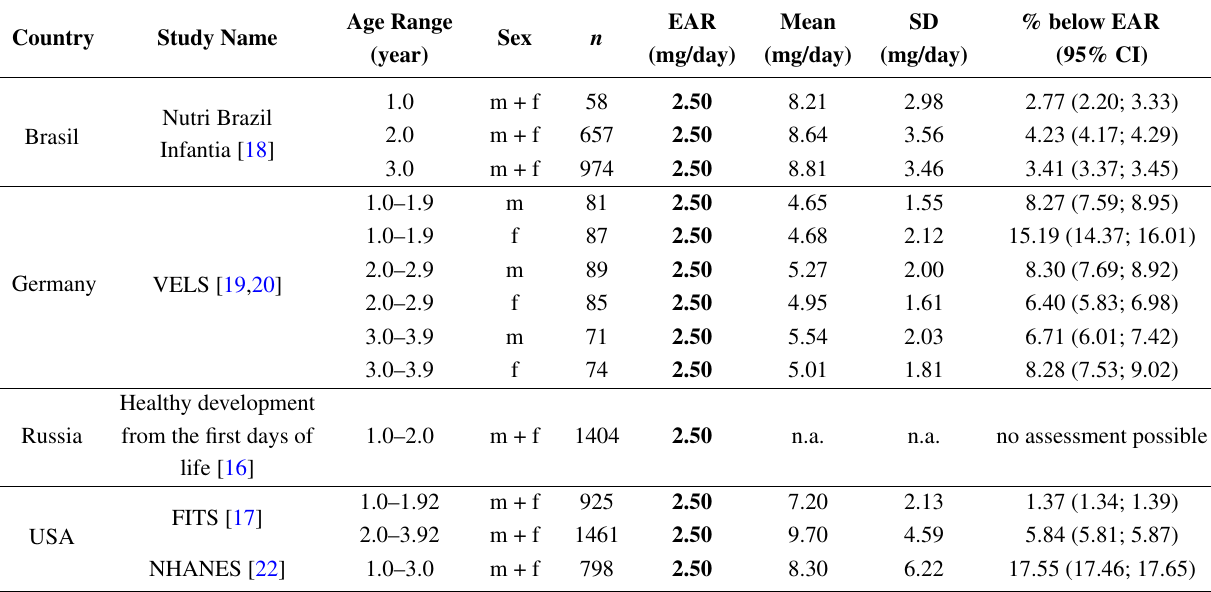
Table 9. Mean zinc intake (mg/day) and prevalence of inadequate intake (% below EAR) in Brazil Germany, Russia and the United